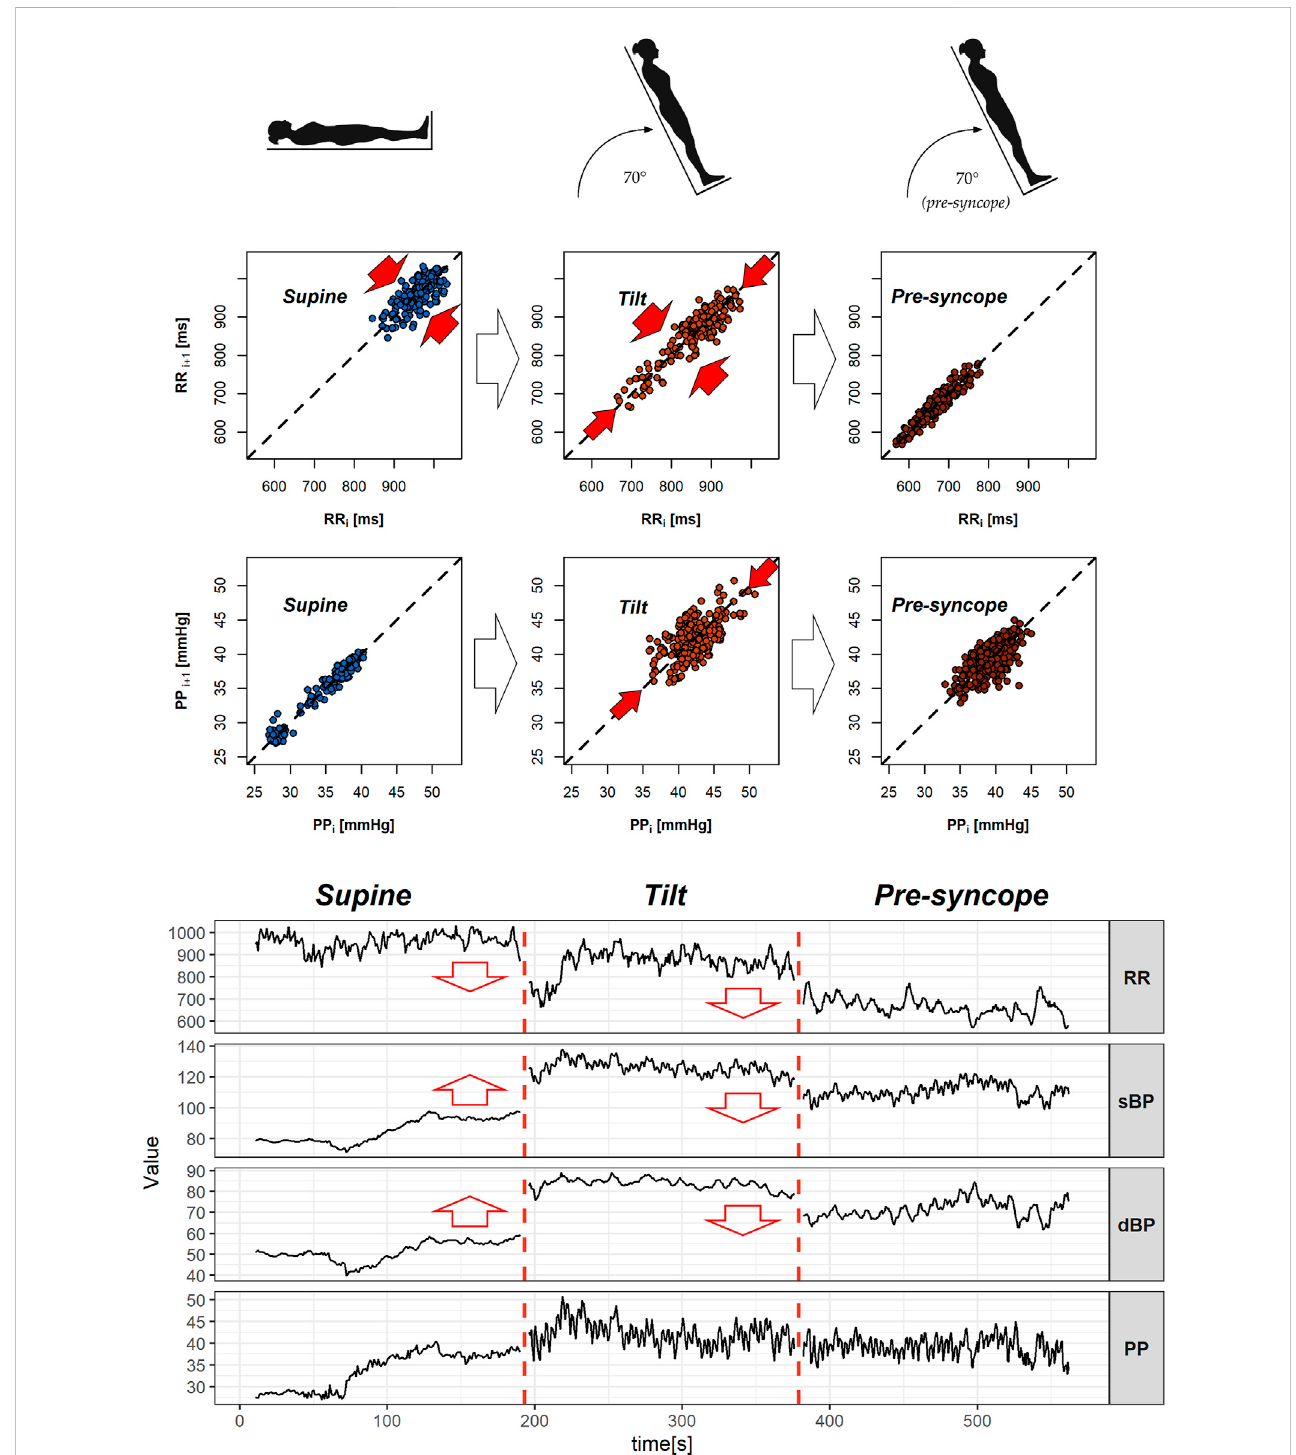
FIGURE 6 Poincaré plots with exemplary heartbeat intervals (RR), pulse pressure (PP) series, signal recordings of heart rate (RR), and blood pressure (sBP, dBP, and PP)ofvasovagalfemalepatients.The fi gurepresents3-minsegmentsofthehead-uptilttestphases — fromtheleft:supine(S1),tilt(T1),andpre-syncopeintilt (T2). Red arrows in the Poincaré plots indicate signi fi cant difference in variability measures (beat-to-beat: SD1 and slow: SD2), while ones in signal graphs represent changes in the mean value between the featured and the following